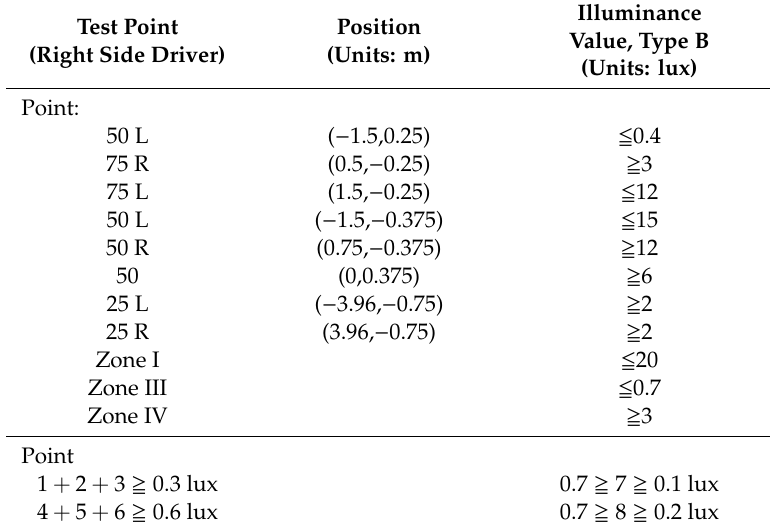
Table 2. ECE R-112 low-beam test